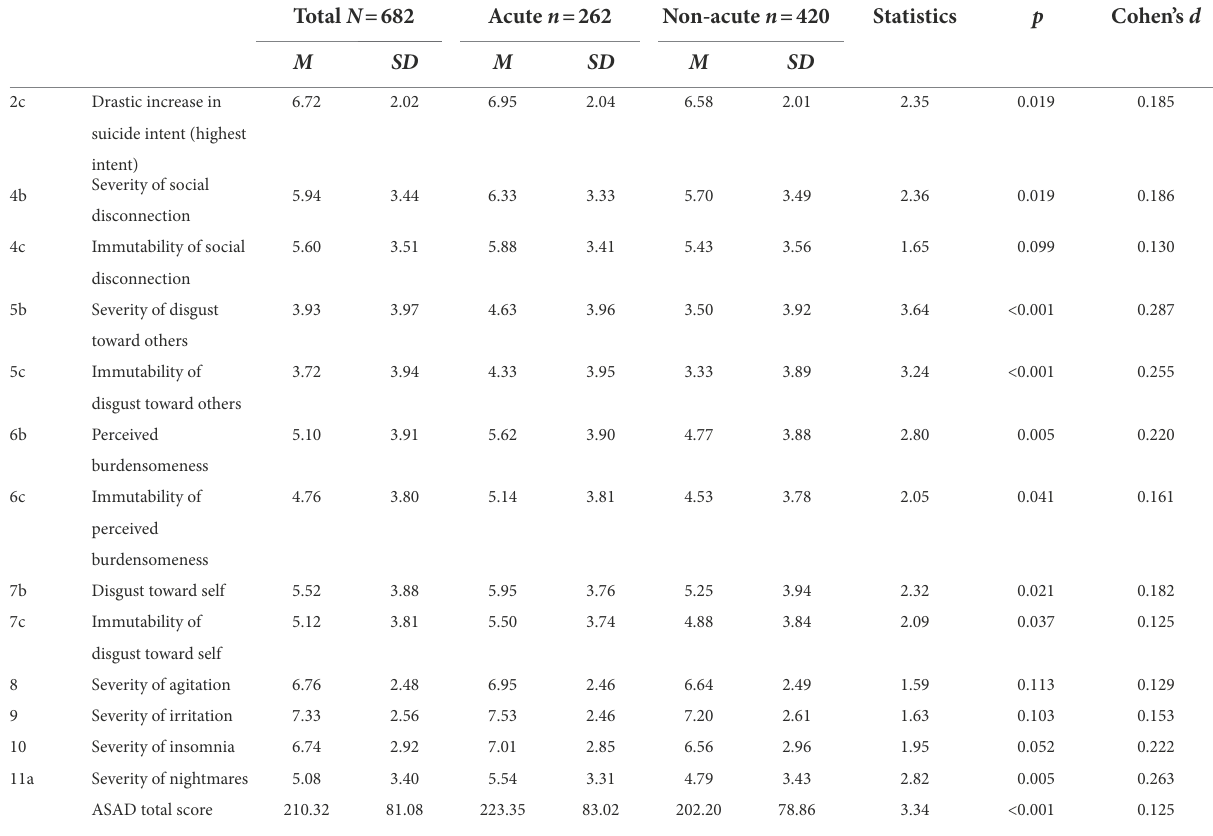
TABLE 1 Descriptive statistics of the acute suicidal affective disturbance inventory-lifetime